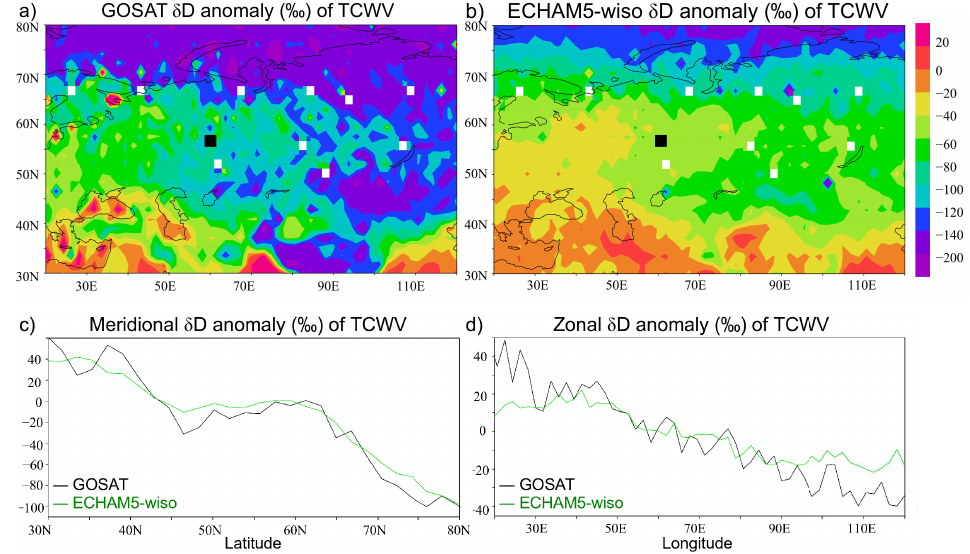
Figure 2. Distribution of annual-mean δ D in total column water vapour, (a) as observed by the GOSAT satellite, (b) as simulated by ECHAM, after collocation with GOSAT observations and convolution with the corresponding averaging kernels. In (a) and (b) the global average of δ D has been subtracted to highlight spatial patterns, and the black squares indicate the location of Kourovka Observatory; white squares are grid cells with low-quality observations. (c) Meridional transects of observed (black) and simulated (green) δ D averaged over the longitude band 50–70 ◦ E around Kourovka. The annual-mean δ D value averaged over the area 30–80 ◦ N, 50–70 ◦ E has been subtracted to highlight the meridional variations. (d) Zonal transects of observed (black) and simulated (green) δ D averaged over the latitude band 50–64 ◦ N around Kourovka. The annual-mean δ D value averaged over the area 50–64 ◦ N, 20–120 ◦ E has been subtracted to highlight the zonal variations.